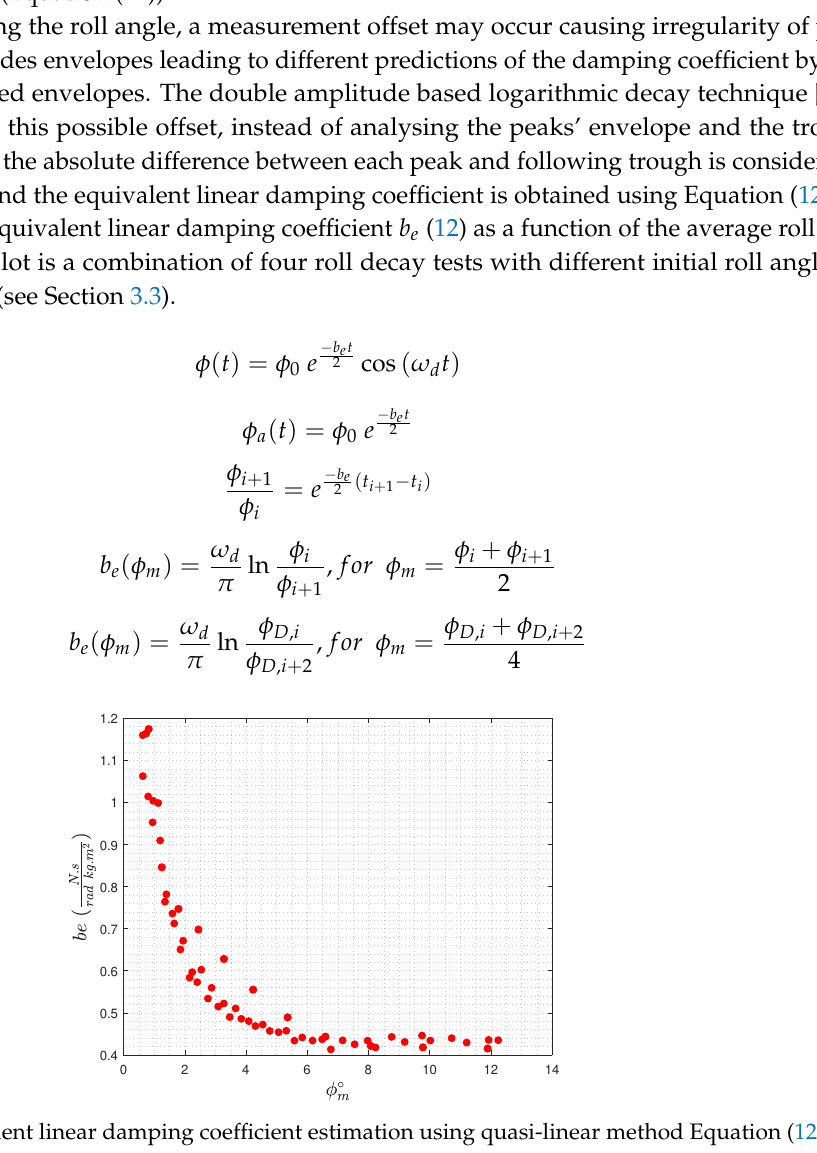
Figure 2. Equivalent linear damping coefficient estimation using quasi-linear method Equation (12), test case 8 by combining results of 4 tests with different initial roll angles, see Section